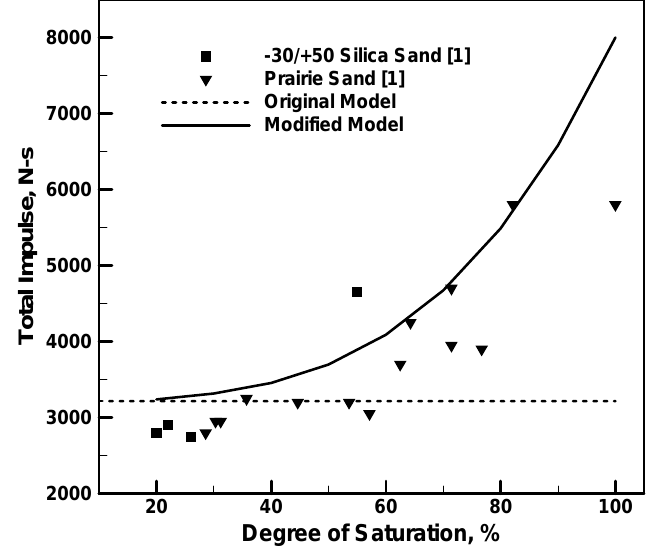
Fig. 5. The effect of degree of saturation and the sand type on the total impulse transferred to the instrumented horizontal mine-impulse pendulum. Explosive weight and type: 1.34 kg C4; Depth of burial: 5 cm. data reported in Ref. [1];